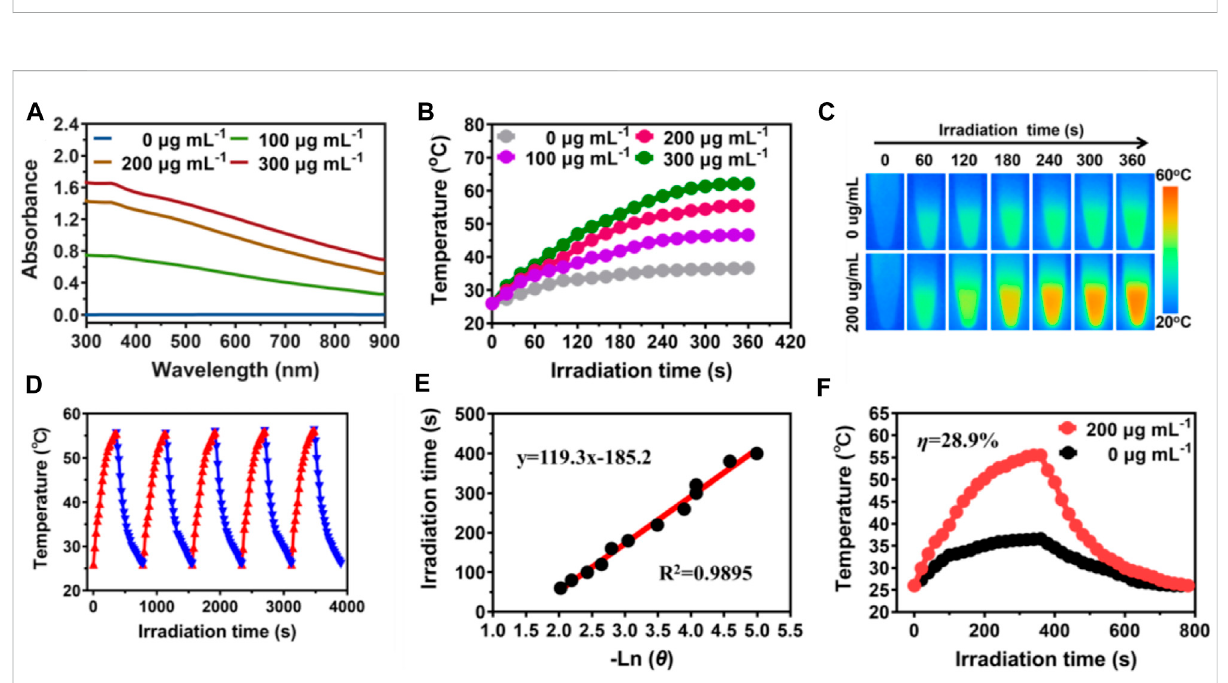
FIGURE 2 Photothermal properties of MPDA. (A) UV-vis-NIR absorption spectra of MPDA dispersions at different concentrations. (B) Photothermal heating curves of MPDA dispersions at different concentrations under 808 nm laser irradiation (1 W cm − 2 ). (C) Infrared thermal images of water and MPDA(200 μ g ml − 1 )underirradiation(808 nm,1 W cm − 2 ). (D) Photothermalstability( fi veON/OFFlasercycles)ofMPDAdispersion(200 μ g ml − 1 ). (E) Linear fi tting plots of time versus ln θ during the cooling period. (F) The photothermal effect of MPDA dispersions (200 μ g/ml, red line) under irradiation (808 nm, 1 W cm − 2 , 6 min) and then switched off the laser (black line is pure water as the